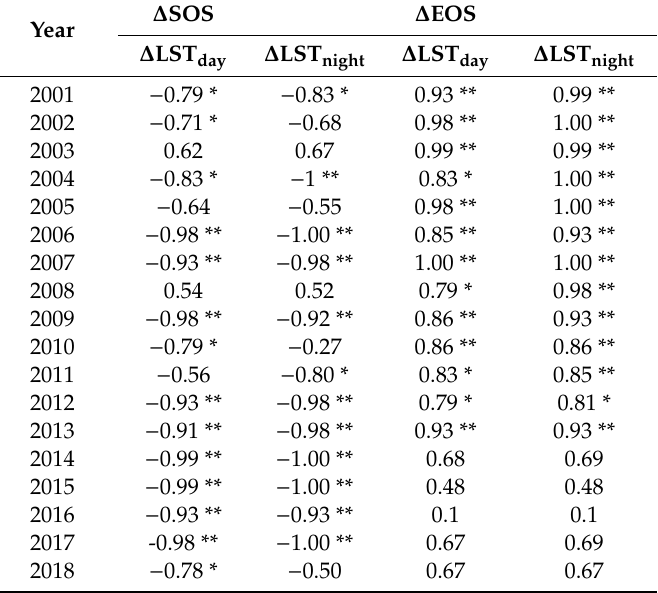
Table 3. Spearman’s correlations between the phenology and land surface temperature (LST) di ff erences across urban and bu ff er areas towards rural